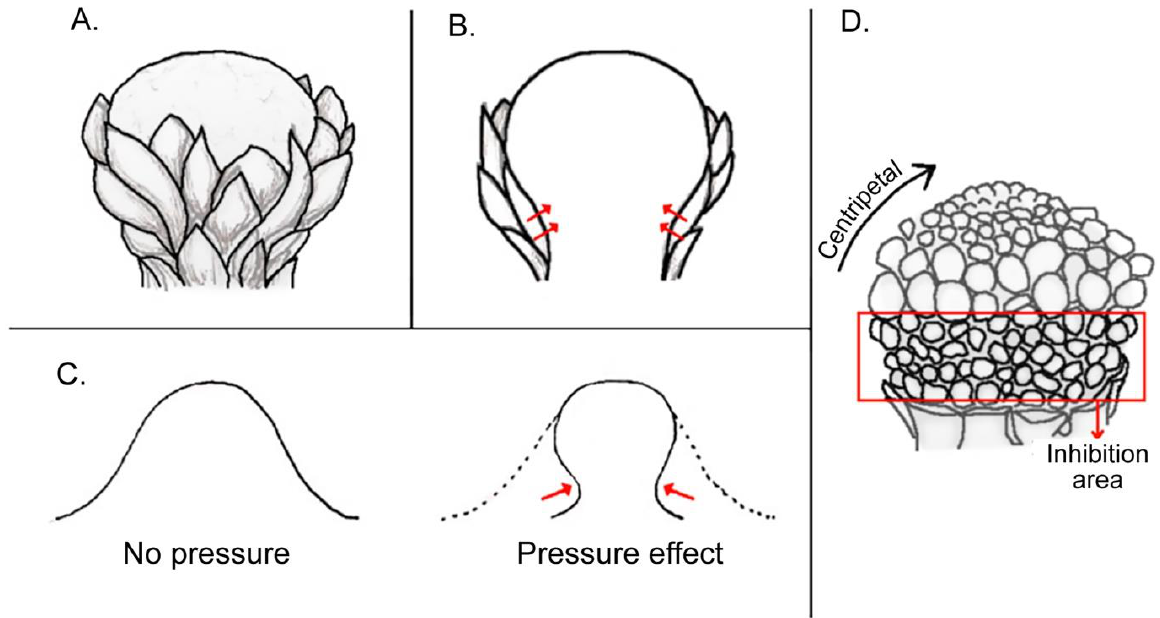
Figure 8. Illustration of compression forces of an involucrum on a central meristem: ( A ) figure of an involucrum formed by several bracts surrounding a central reproductive meristem. ( B ) Longitudinal section of Figure A, showing pressure exerted by involucrum at the base of the meristem (red arrows). ( C ) Diagram of a typical FUM, i.e., a head meristem, showing centripetal progression of florets in the upper part and delayed floret growth at its base in area of inhibition covered by involucrum. ( D ) Silhouette of a terminal meristem without (left) and with an involucrum (right). Red arrows denote deformation of the meristem by an involucrum.